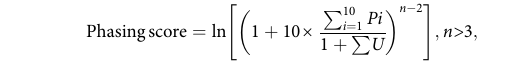
Table 2. A fragment (ATGGCGCCAAAAAAGAAGAGAAAGGTC) encoding an NLS 32 was fused with GFP by PCR with primers PstI-NLS-BamHI-GFP-F and GFP-SacI- R to construct an NLS-GFP fragment. The NLS-GFP fragment was cloned into pMDC7 43 via LR clonase II (Invitrogen) to generate pMDC7-NLS-GFP. The genomic region without the stop codon of SNC1 (At4g16890) was ampli fi ed from Col genomic DNA with primers SNC1-KpnI-F and SNC1-PstI-R, and fused with NLS-GFP. The SNC1-NLS-GFP fragment and the SNC1 fragment were cloned